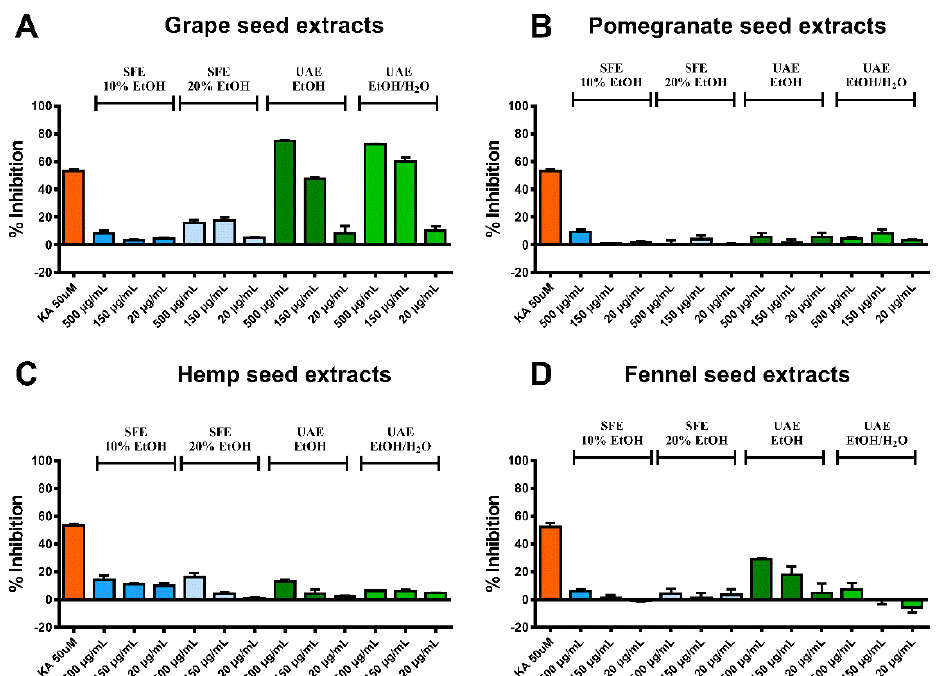
Figure 1. Results of the tyrosinase activity assay. The percentage of tyrosinase enzyme inhibition (%) is presented for the produced extracts from ( A ) grape seeds, ( B ) pomegranate seeds, ( C ) hemp seed and ( D ) fennel seeds. Kojic acid (KA) was used as positive control.